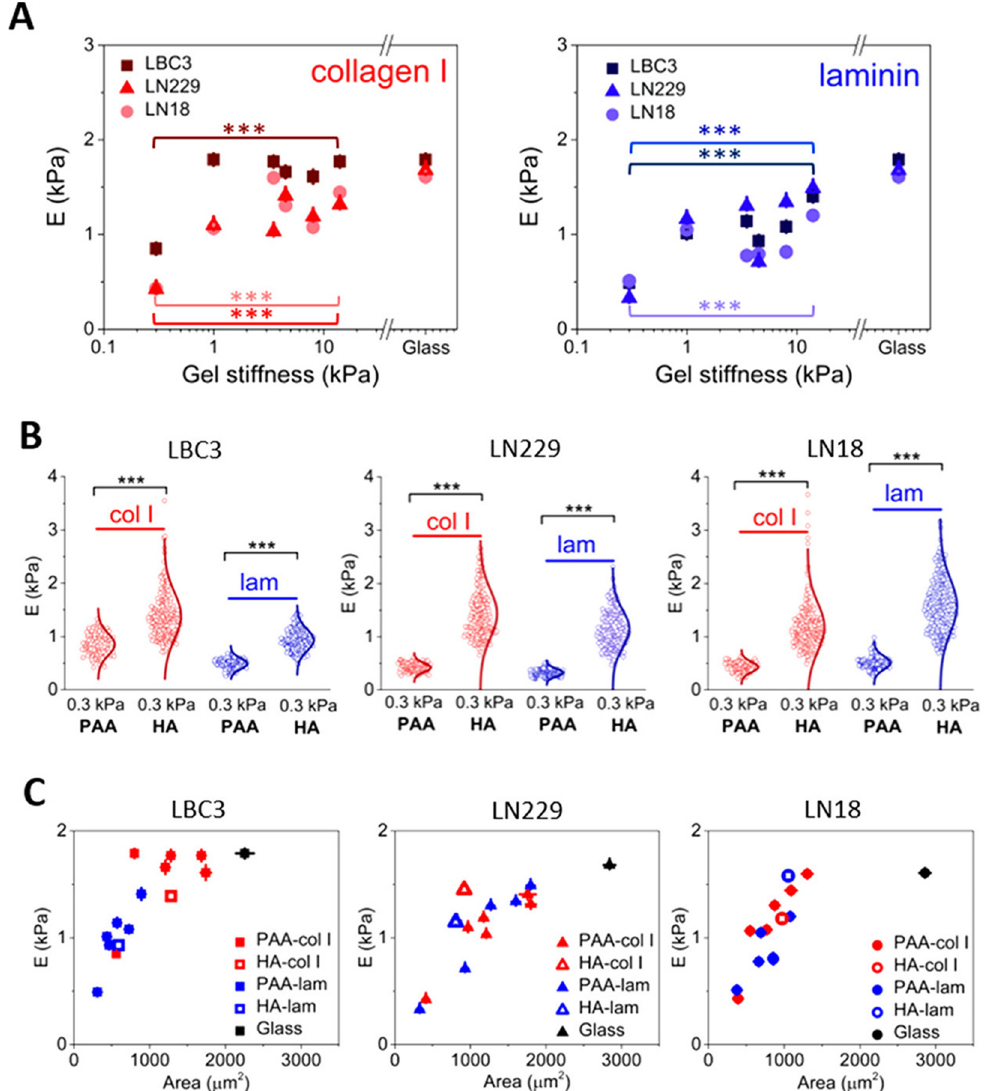
Figure 8. Regulation of glioblastoma cell rigidity by substrate composition and stiffness. ( A ) Cellular stiffness as a function of substrate stiffness for collagen I or laminin-coated PAA hydrogels. ( B ) Vari- ations in the cell stiffness when PAA is replaced by HA. ( C ) The stiffness of GB cells as a function of their spreading area. The unpaired Student’s t-test was used to confirm significant differences in cell stiffness between in panels A (between 0.3 and 14 kPa PAA gels) and B (between 0.3 kPa PAA and 0.3 kPa HA); denotation: ***, p < 0.00). Figure adapted with permission from Ref. [17]. 2017, Pogoda K.